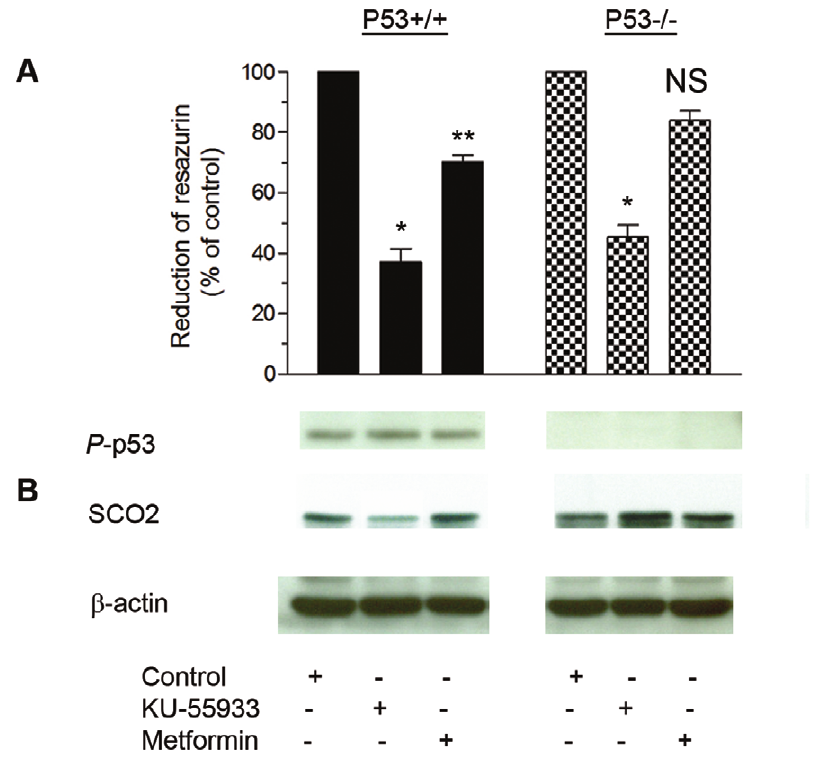
Figure 5. Effects of KU-55933 on HCT116 p53 + / + and HCT116 p53 2 / 2 cells. Cells were seeded into 96-well plates with 10% FBS and after 24 hrs. exposed to KU-55933 (10 m M) or metformin (5 mM) in DMEM containing 1% FBS for 72 hrs. ( A ) Cell growth was estimated by Alamar Blue dye reduction. Results are presented as mean 6 S.E.M. from 3 independent experiments in triplicate. HCT116 p53 + / + cell growth was significantly inhibited by both KU-55933 (*P , 0.0001) and metformin (** P =0.0013). For HCT116 p53 2 / 2 cells, KU-55933 significantly inhibited growth (* P =0.0002), but this effect was not seen with metformin exposure ( P =0.223). ( B ) Under the above conditions, after harvesting, cells were lysed and prepared for immunoblot analyses using antibodies against phosphorylated p53 (Ser 15 ), and SCO2. ß-actin is shown as a loading